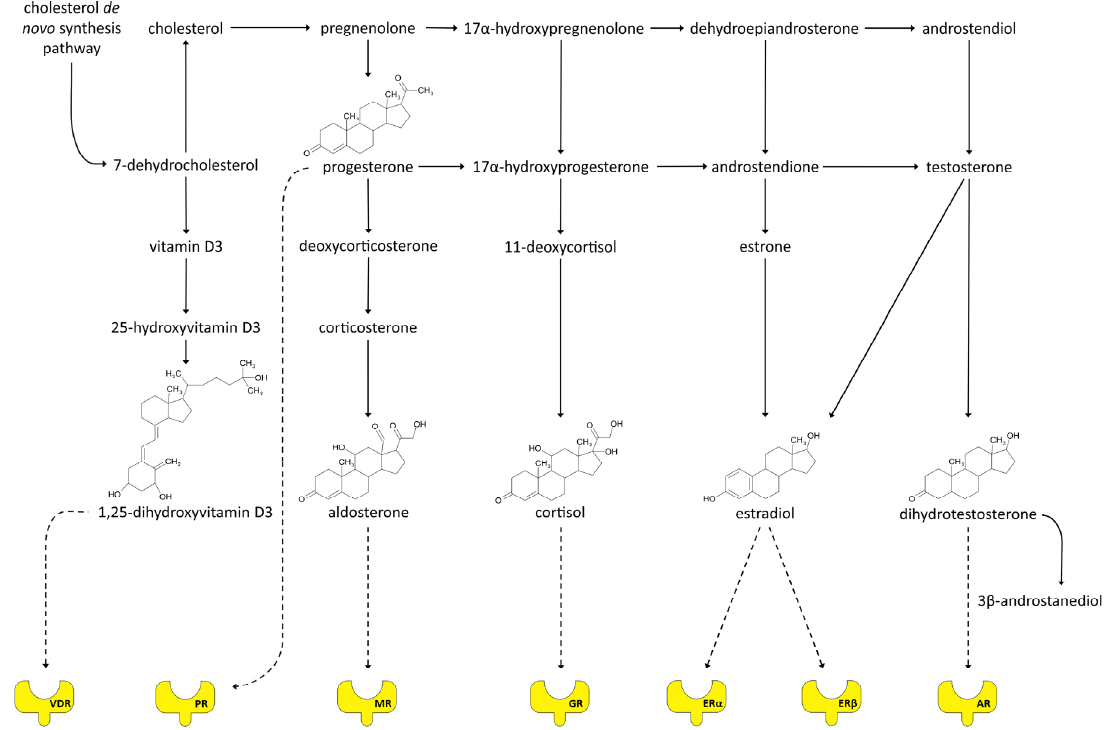
Figure 1. Structure and synthesis of ligands for SRs and VDR. Structures are shown only for steroids of highest affinity to their target receptor [4,6]. Since ER α and ER β are encoded by different genes they are shown separately. Solid lines should be read as “is metabolized to” and dotted lines as “binds to”. Illustration created using elements